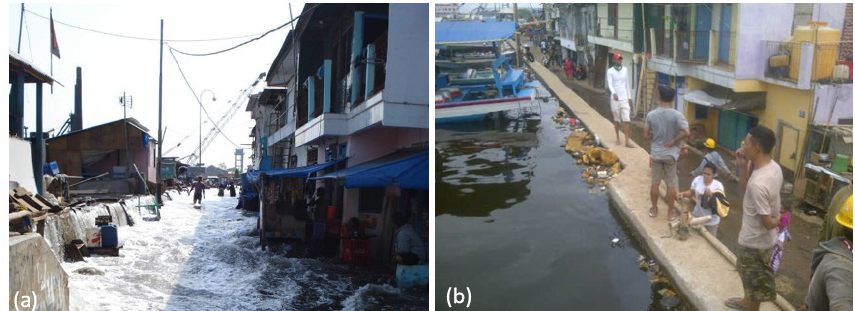
Figure 5. The district of Pluit in Jakarta is situated below sea level. The area suffered extensive inundation during high tide on 26 November 2007 (left). The thin dyke protecting the settlement was raised by about a metre after the 2007 high-tide event by the local government, obstructing people’s view of the sea. The photo was taken on 18 October 2013 (right). (Photos: courtesy of Brinkman, J. J., Deltares).